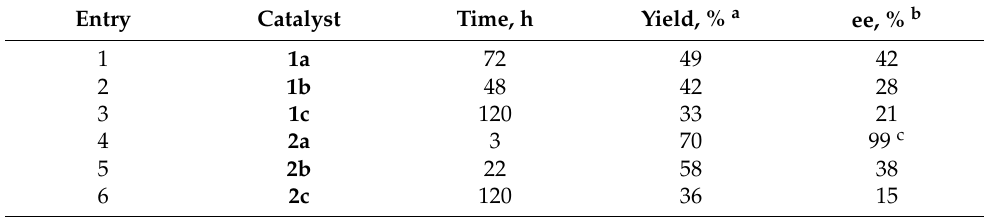
Table 3. Effect of the glucose-based macrocycles ( 1 or 2 ) in Michael addition of β -nitrostyrene ( 14 ) and diethyl acetamidomalonate ( 15 ).